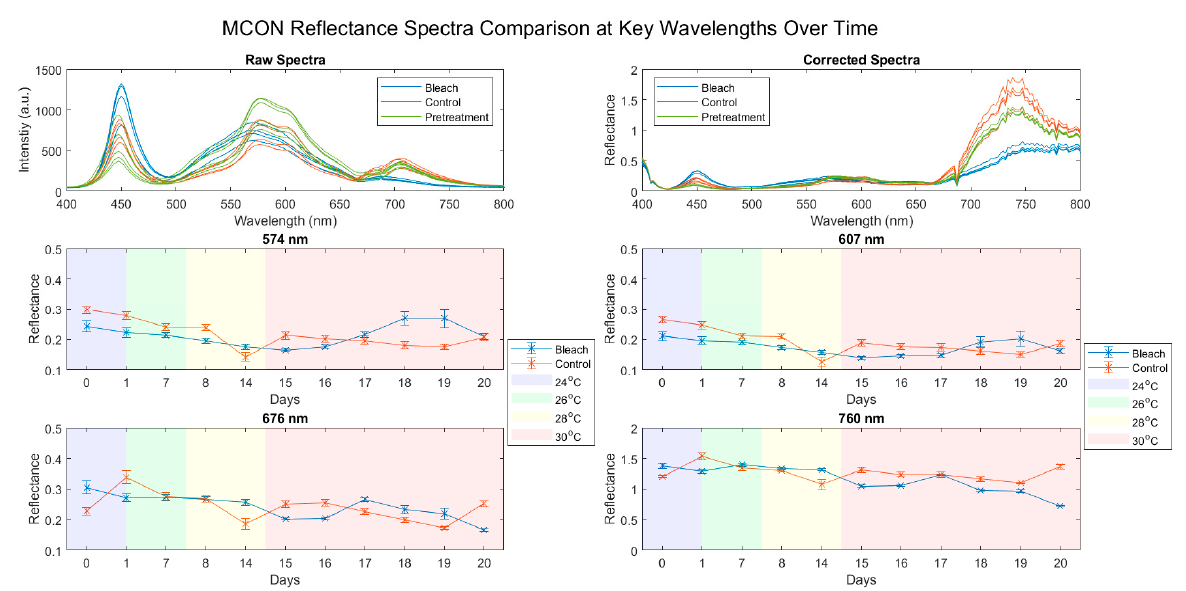
Figure 3. Raw & corrected reflectance spectra and reflectance of key wavelengths of Montipora confusa (MCON) over time imaged under white light in experiment 2. The average intensity at each wavelength per day of treatment is presented, where the temperature regime is represented as the blue section corresponding to 24 °C (the control stayed at this temperature throughout), green to 26 °C, yellow to 28 °C and red to 30 °C.